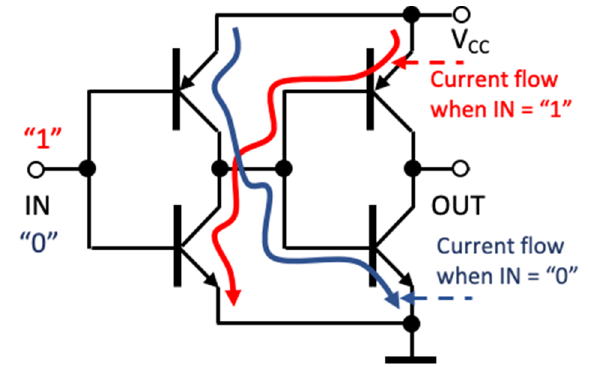
Figure 13. Current flow in bipolar inverters (see also [27]).